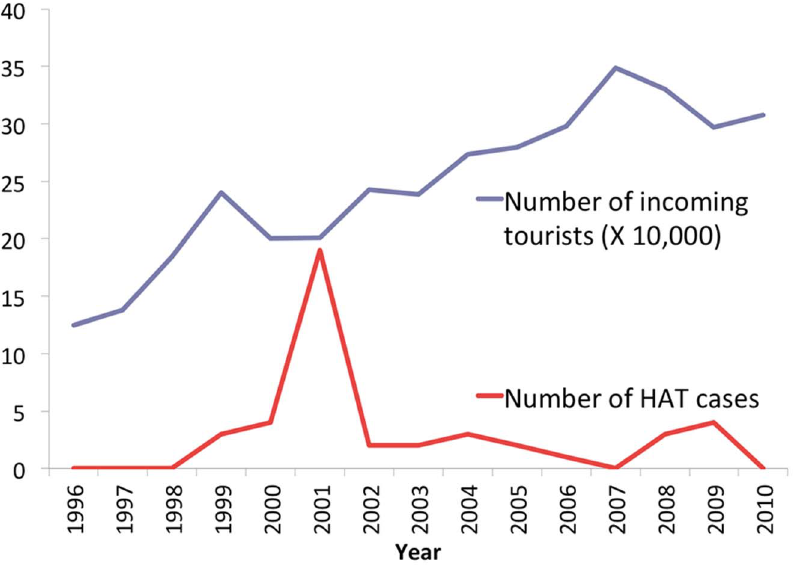
Figure 3. Number of incoming tourists and number of HAT cases among patients from non-endemic countries in Tanzania during 1995–2010.